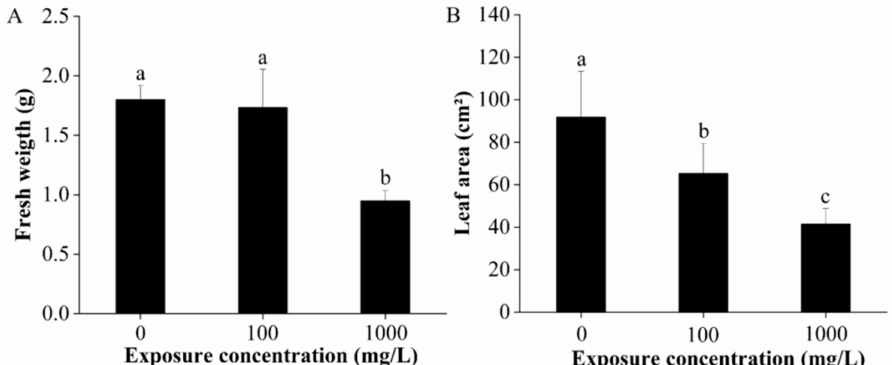
Figure 1. Fresh weight ( A ) and leaf area ( B ) of lettuce after 15 days of foliar exposure to CuO-NPs (0, 100, and 1000 mg/L). Values are expressed as the mean of five replicates ( ± SD) for each treatment; the different lowercase letters (a, b, and c) indicate significant difference at p < 0.05 among different exposure concentrations, mean values with the same letter are not significantly